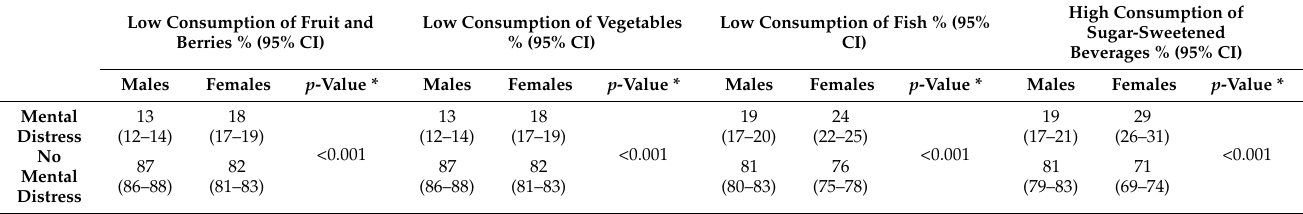
Table 2. Differences in mental distress between males and females with unhealthy dietary habits. Low Consumption of Fruit and Berries % (95% CI)